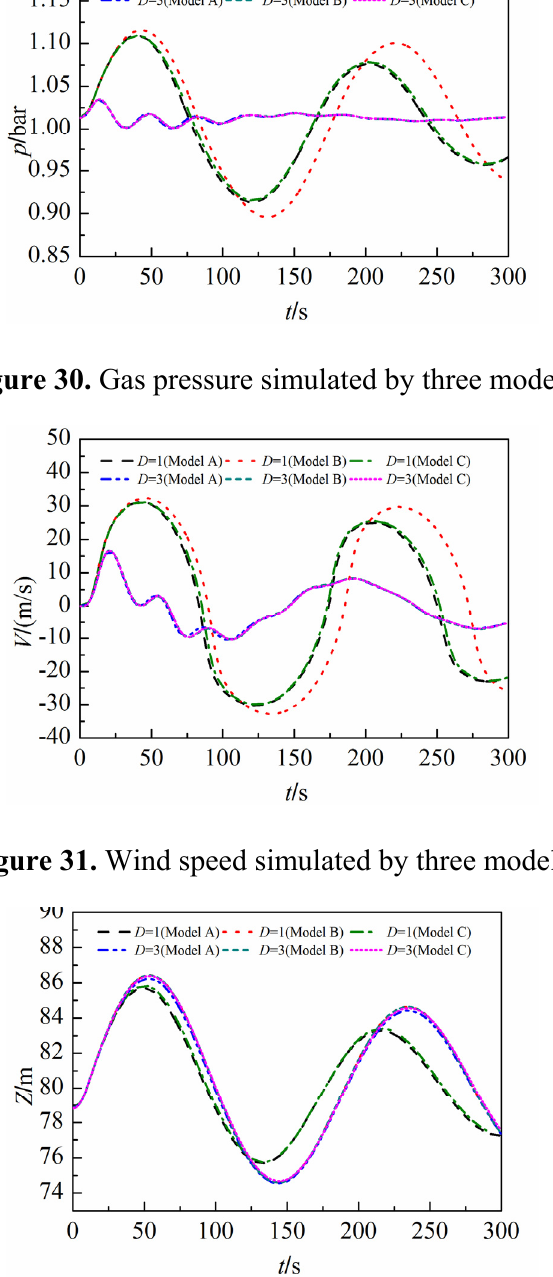
Figure 32. Water level fluctuations simulated by three